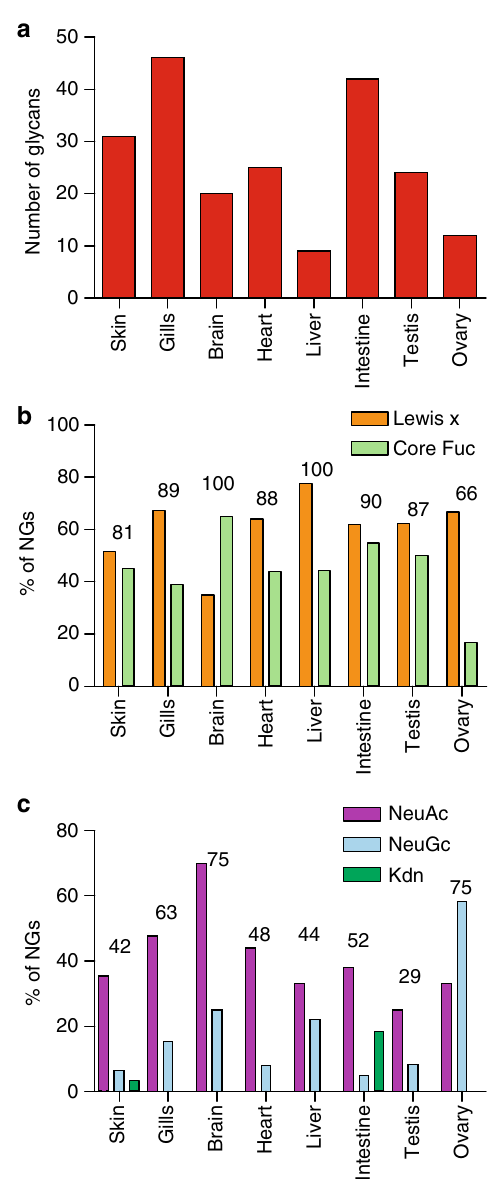
Fig. 4 Comparison of NGs features between organs. a Number of NGs con fi dently identi fi ed in each organ. b Fucosylation pattern expressed as the proportion of NGs substituted by one or more fucoses on the chitobiose disaccharides (green bars, core Fuc), and/or in Lewis-x epitope (orange bars); numbers indicate the overall percentage of fucosylated NGs. c Sialylation pattern expressed as the percentage of NGs substituted by any of the three sialic acids (purple bars, Neu5Ac; light blue bars, Neu5Gc; green bars, Kdn); numbers indicate the overall percentage of sialylated NGs relative to total NGs in the corresponding organs. It should be noted that a single NG may bear both Lewis-x and core Fuc, as well as different types of sialic are Gal β 1-3(Neu5Ac α 2-6)GalNAc-ol (OG2), and Neu5Ac α 2-